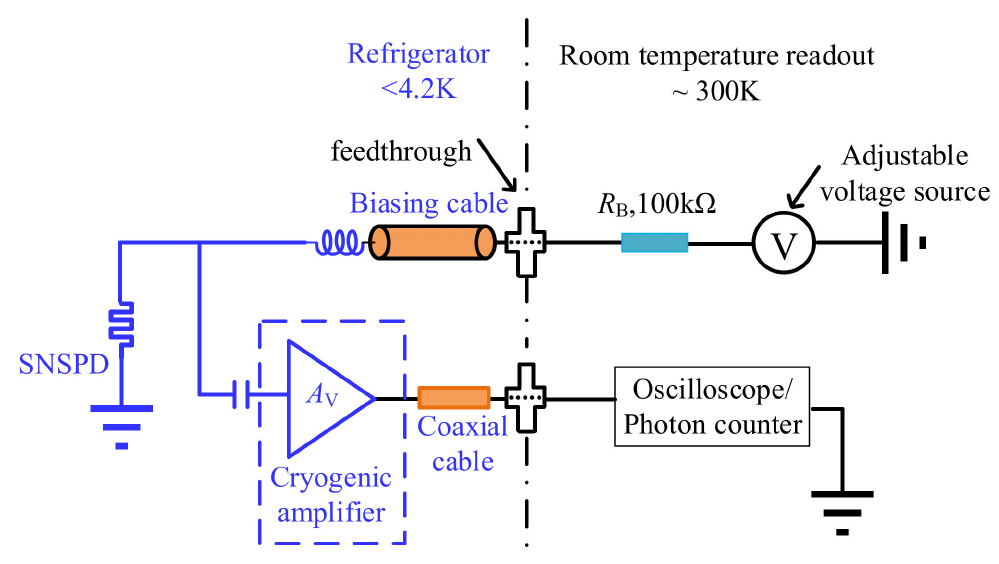
Figure 2. The cryogenic SNSPD readout